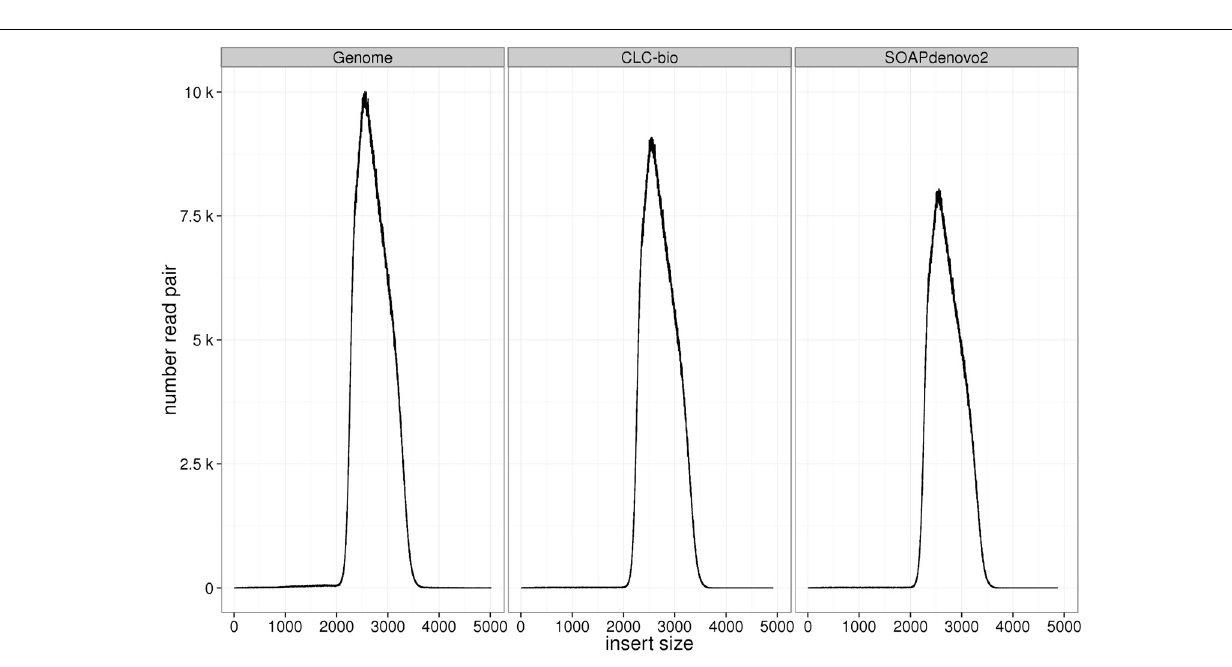
FIGURE 6 | Estimation of insert sizes for E. coli mate pair library. Insert sizes are plotted using reads mapped against E. coli reference genome, CLC, and SOAPdenovo2 assemblies.